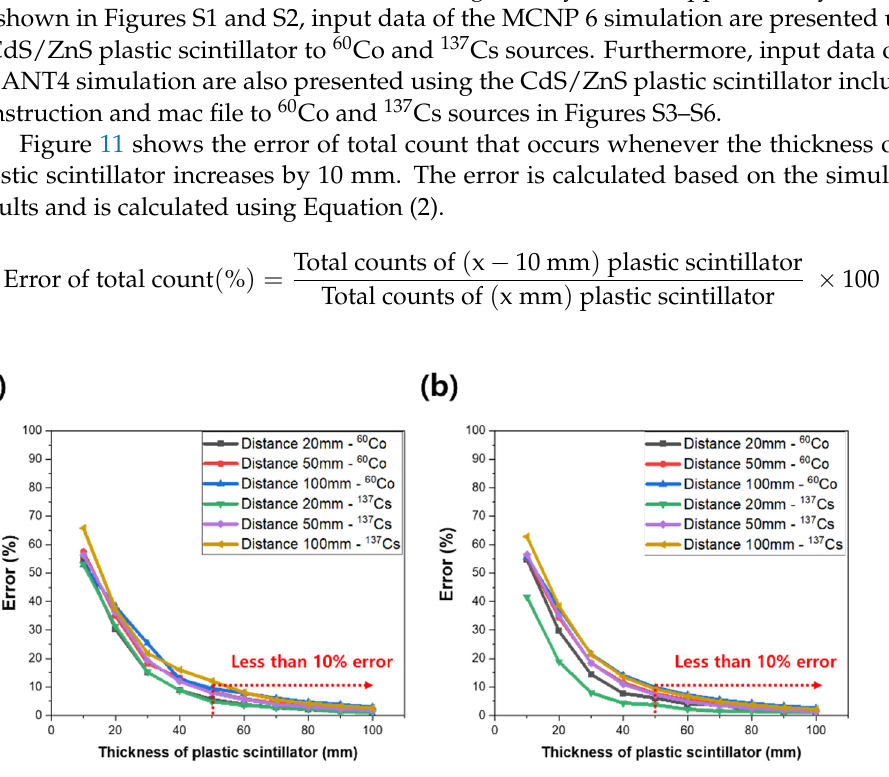
Figure 11. Error caused by increasing the plastic thickness (%): ( a ) commercial plastic scintillator; ( b ) CdS/ZnS-loaded plastic ( b ) CdS/ZnS-loaded plastic scintillator.